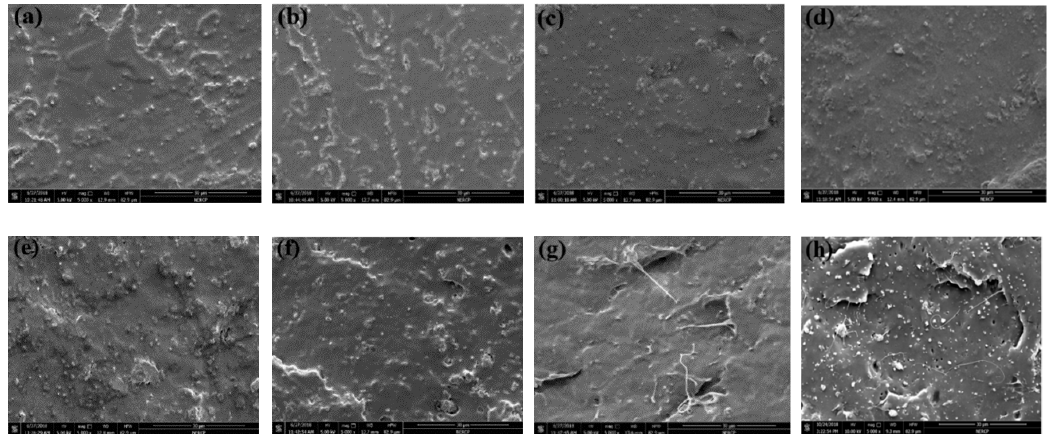
Figure12. SEMmicrographsofPLAanditscomposites: ( a )PLA;( b )PLA / SAL / ESO1; ( c )PLA / SAL / ESO2; Figure 12. SEM micrographs of PLA and its composites: ( a ) PLA; ( b ) PLA/SAL/ESO1; ( c ) ( d ) PLA / SAL / ESO3; ( e ) PLA / SAL / ESO4; ( f ) PLA / SAL / ESO5; ( g ) PLA / ESO; ( h ) PLA / lignin / PLA/SAL/ESO2; ( d ) PLA/SAL/ESO3; ( e ) PLA/SAL/ESO4; ( f ) PLA/SAL/ESO5; ( g ) PLA/ESO; ( h ) PLA/lignin/ESO.